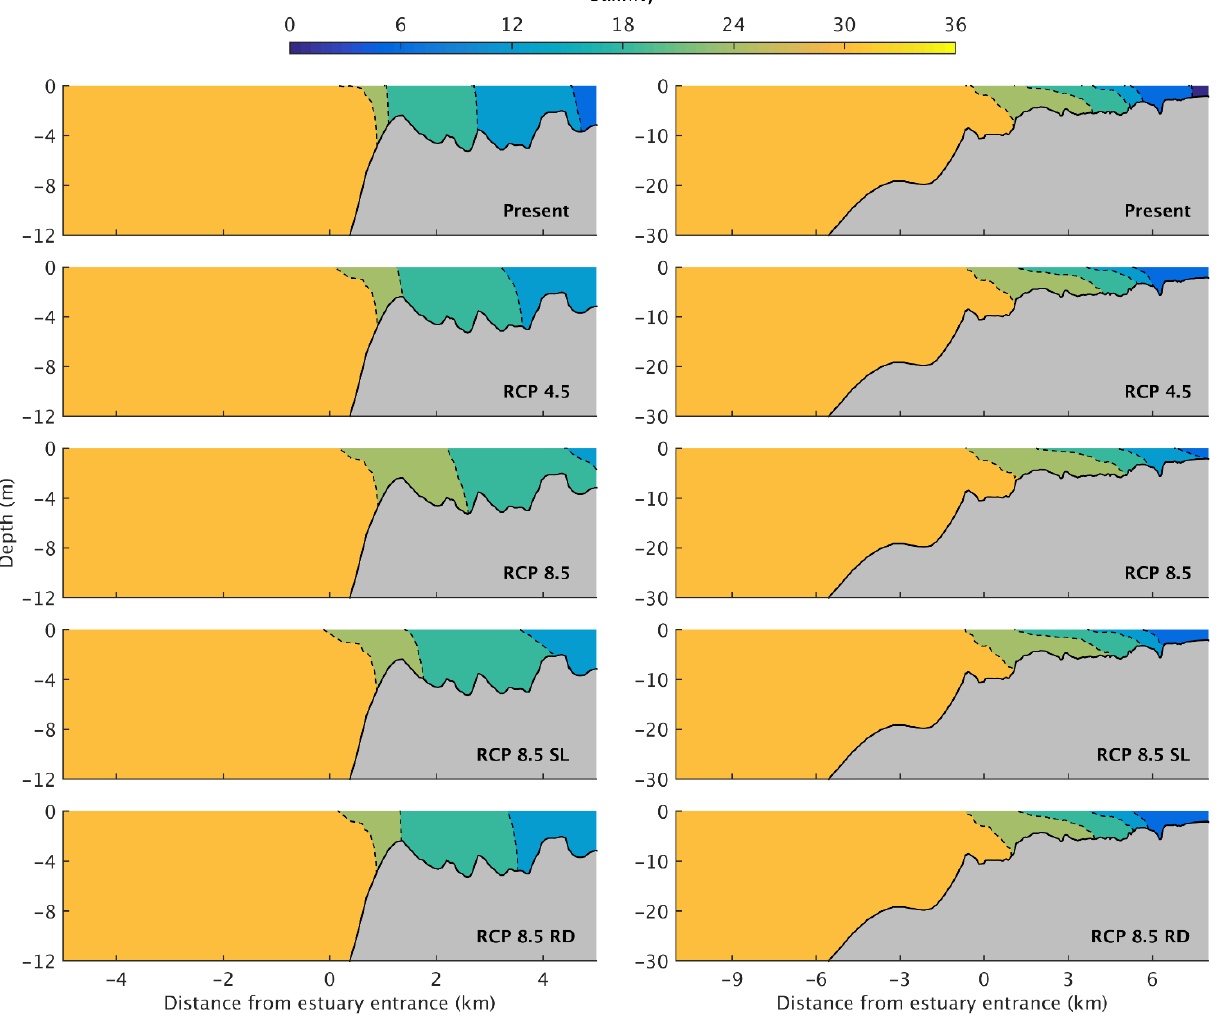
Figure 10. Vertical salinity distribution along the plume/estuary during summer conditions for the Present, RCP 4.5, and RCP 8.5 scenarios. The ( left ) panel represents the Minho estuary and the ( right ) panel the Lima